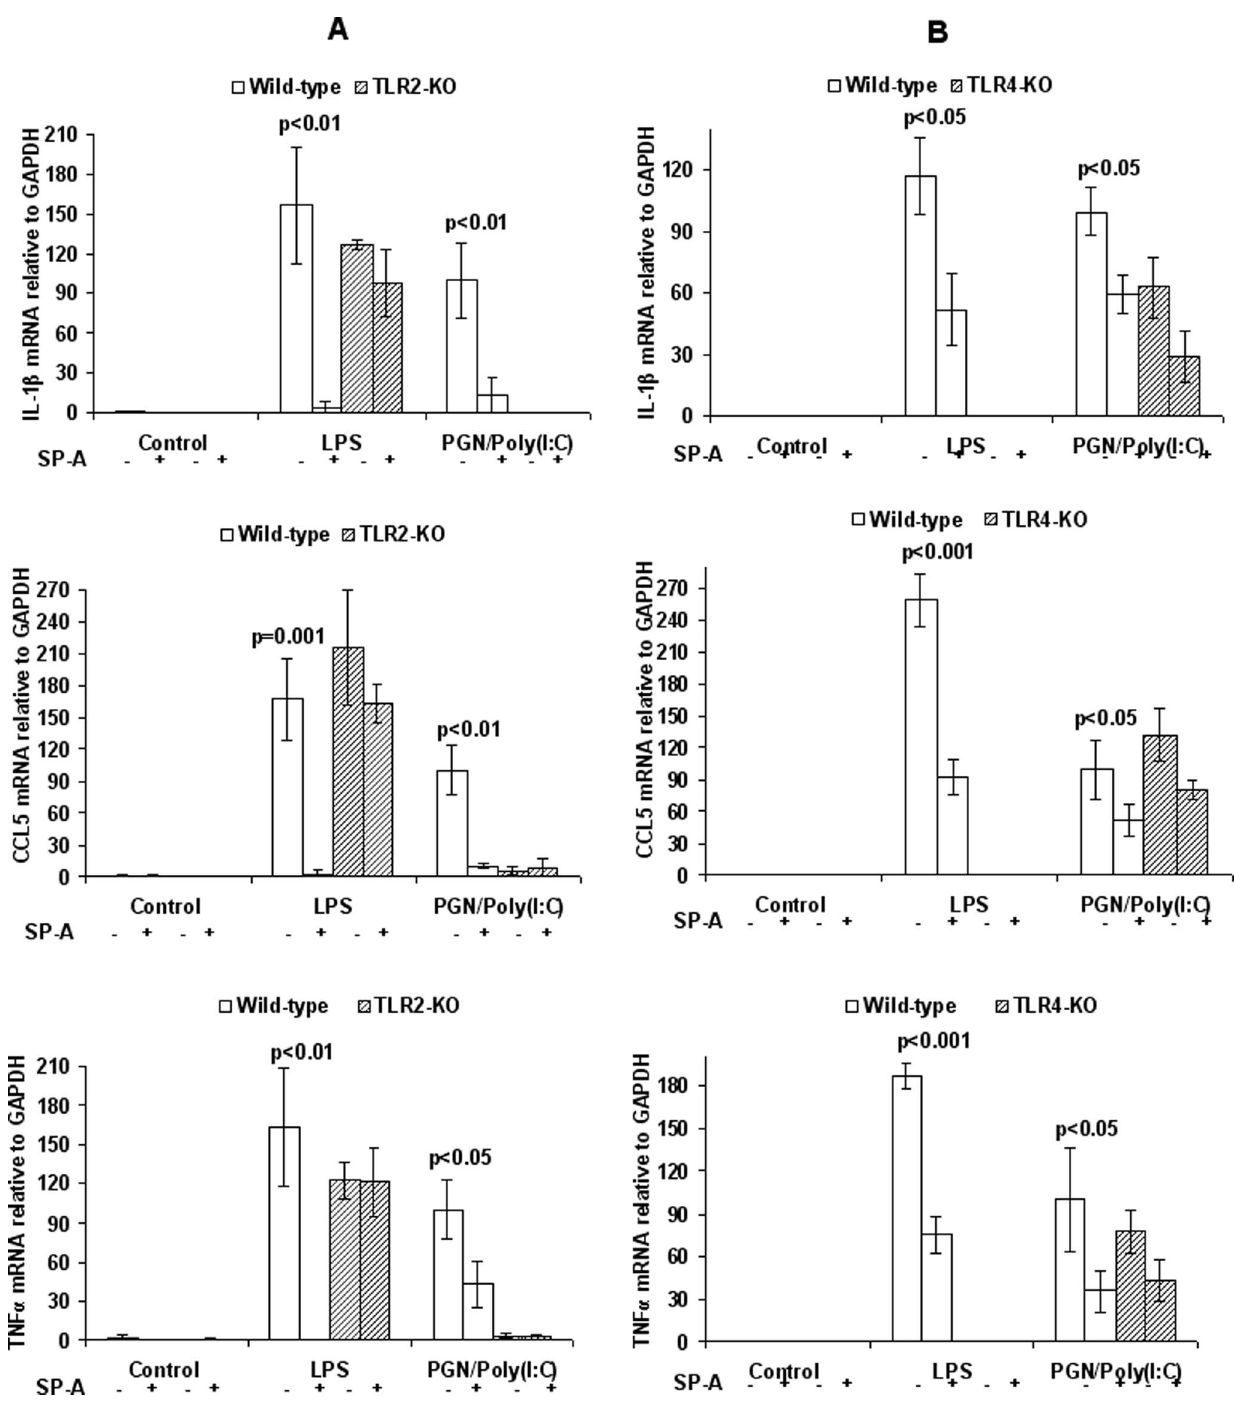
Figure 3. The anti-inflammatory effect of SP-A requires TLR2. Expression by RT-PCR of IL-1 b , CCL5 and TNF- a in WT and (Panel A) TLR2-KO and (Panel B) TLR4-KO peritoneal macrophages after treatment with PBS, LPS, or PGN + poly(I:C), with or without SP-A. P values were calculated by ANOVA and compare four treatment groups (KO or WT with or without SP-A) for each TLR ligand . n=3 replicates per condition per experiment. Depicted is a representative figure from three repeat experiments. Error bars=standard deviation. Values for the PGN + Poly(I:C) group were set to 100.